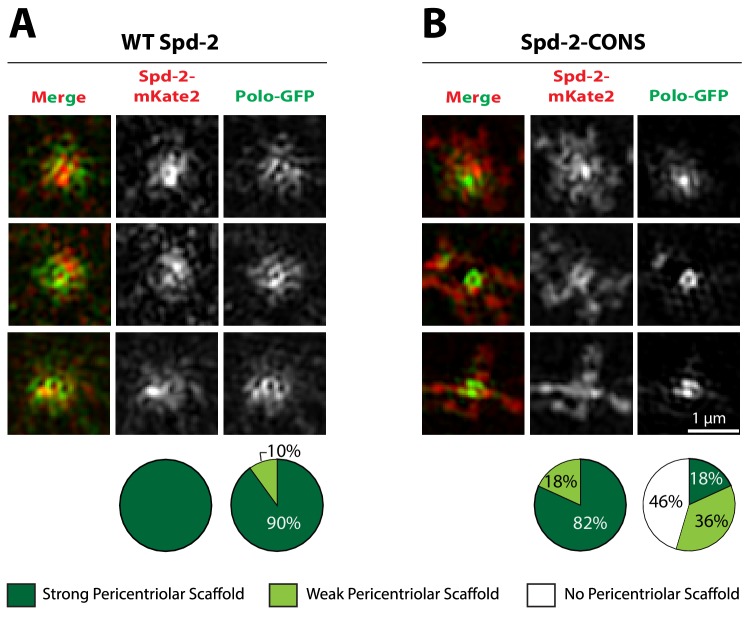
The recruitment of Polo-GFP to the PCM is perturbed in embryos expressing Spd-2-CONS-mKate2, even if a PCM scaffold is still detectable.(A,B) Micrographs show 3D-SIM images of individual centrosomes from embryos expressing Polo-GFP (green in merged images) injected with mRNA encoding either WT Spd-2-mKate2 (A) or Spd-2-CONS-mKate2 (B) (red in merged images). Pie charts quantify the percentage of centrosomes that were scored qualitatively as having a strong (dark green), weak (light green) or no (white) pericentriolar scaffold (n = 10 and 11 individual centrosomes, two images (channels) per centrosome, for WT and CONS injections, respectively). All centrosomes were imaged in mid-late S-phase when the centrosomal levels of Spd-2 are maximal (see Figure 8). All scorings were performed blind by researchers not involved in the data acquisition. Note that mKate2 is relatively slow folding, and the fusion proteins are just expressed from the injected mRNA, so the signal-to-noise ratio is low and the 3D-SIM images reconstruct relatively poorly. Nevertheless the presence of a Spd-2-CONS-mKate2 scaffold is clear, even when the Polo-GFP signal in the scaffold is very weak (B).10.7554/eLife.50130.049Figure 10—source data 1.Figure 10 source data, results from blind scoring.